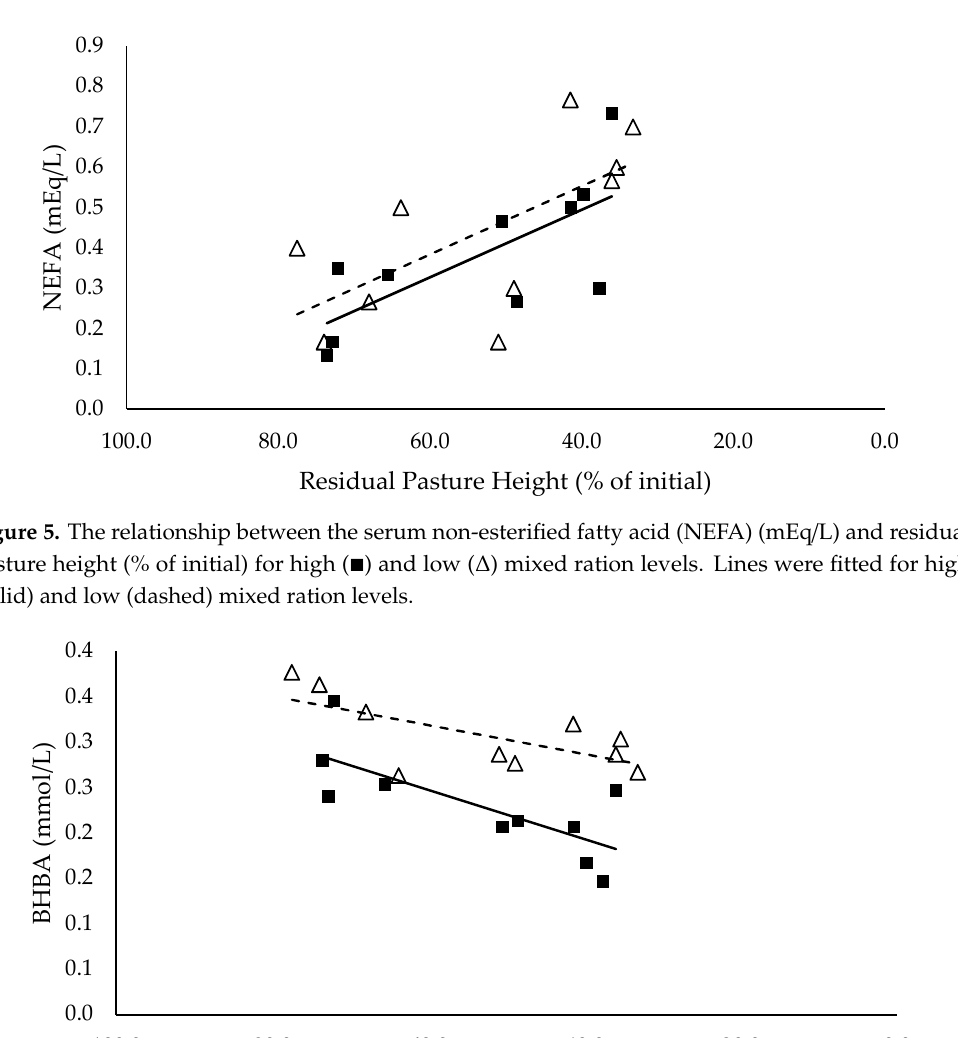
Figure 4. The relationship between pasture intake rate (kg DM/cow/h) and residual pasture height (% of initial) for high ( ■ ) and low (Δ) mixed ration levels. Lines were fitted for high (solid) and low (dashed) mixed ration levels.